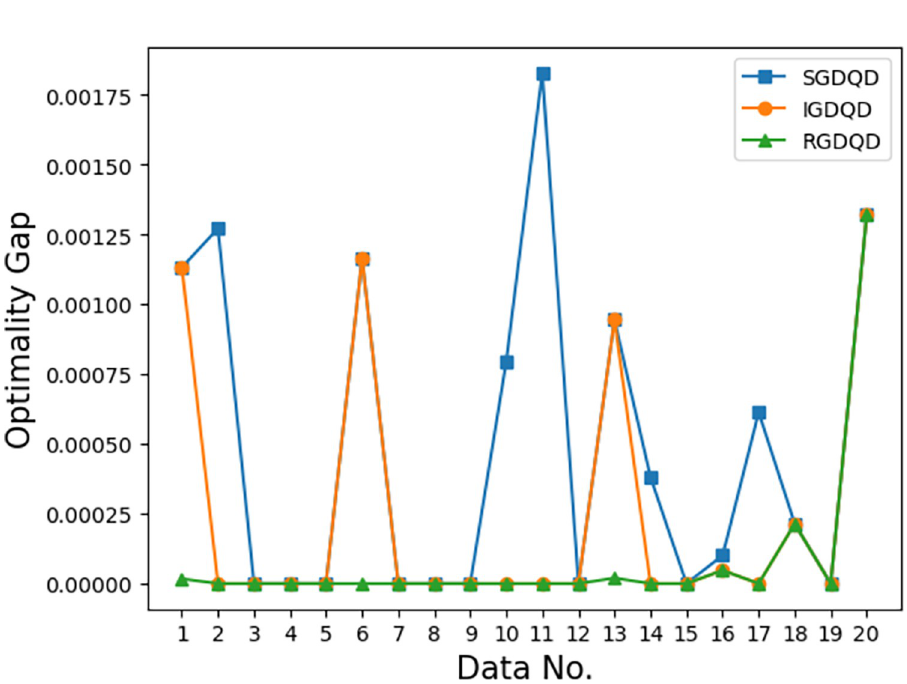
Fig 11. Comparison of optimality gaps for Q = 300000.